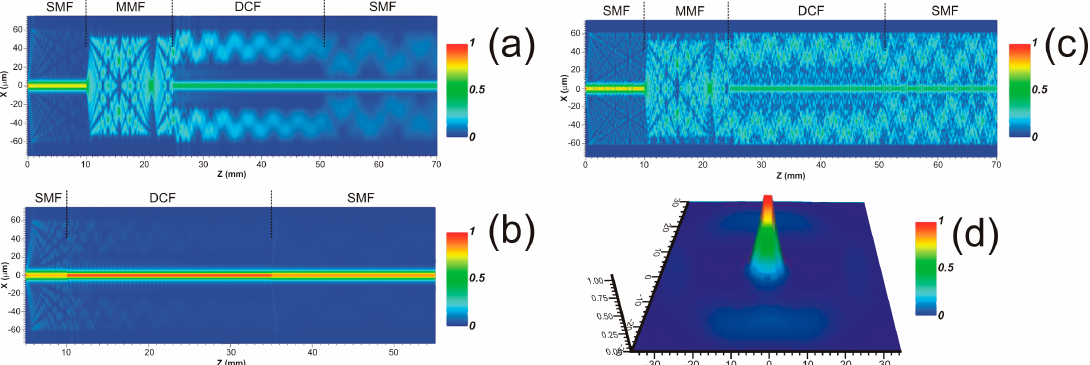
Figure 2. BPM Simulations of intensity distribution in the xz plane for: ( a ) used SMDS; ( b ) SDS structure; ( c ) SMDS without black paint application on the structure surface; ( d ) BMP simulation of the three-dimensional optical field amplitude profile of the SMDS structure at the output SMF.